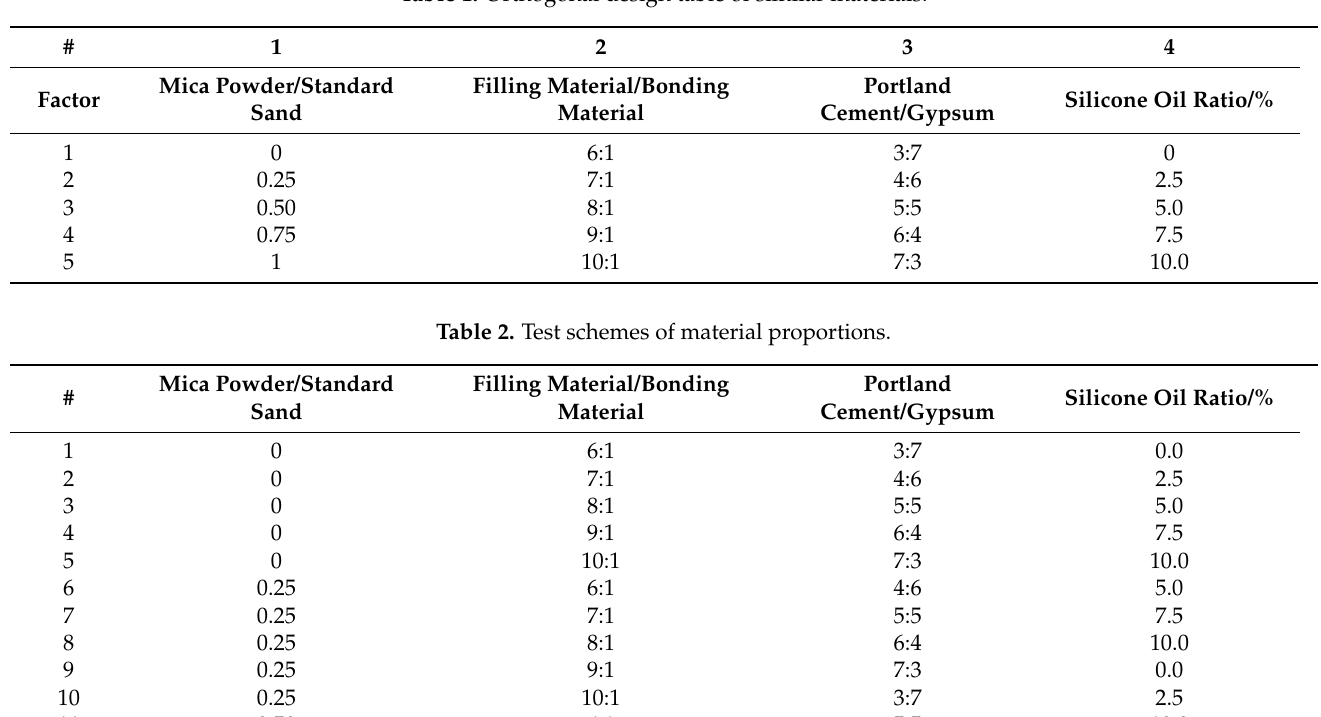
Table 1. Orthogonal design table of similar materials.